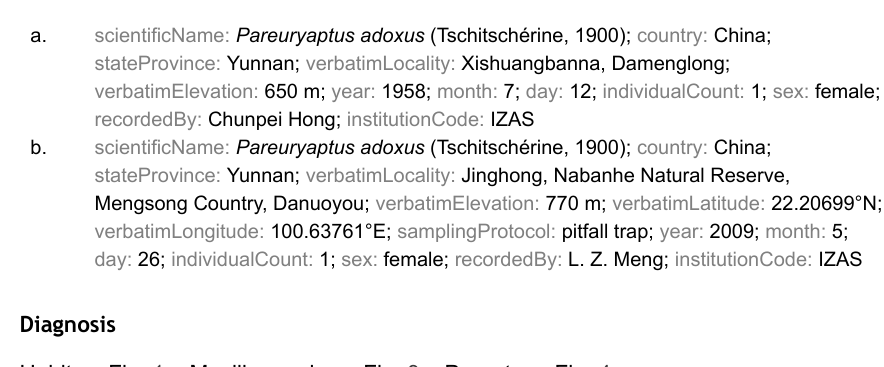
Habitus: Fig. 1a. Maxillary palpus: Fig. 3a. Pronotum: Fig.